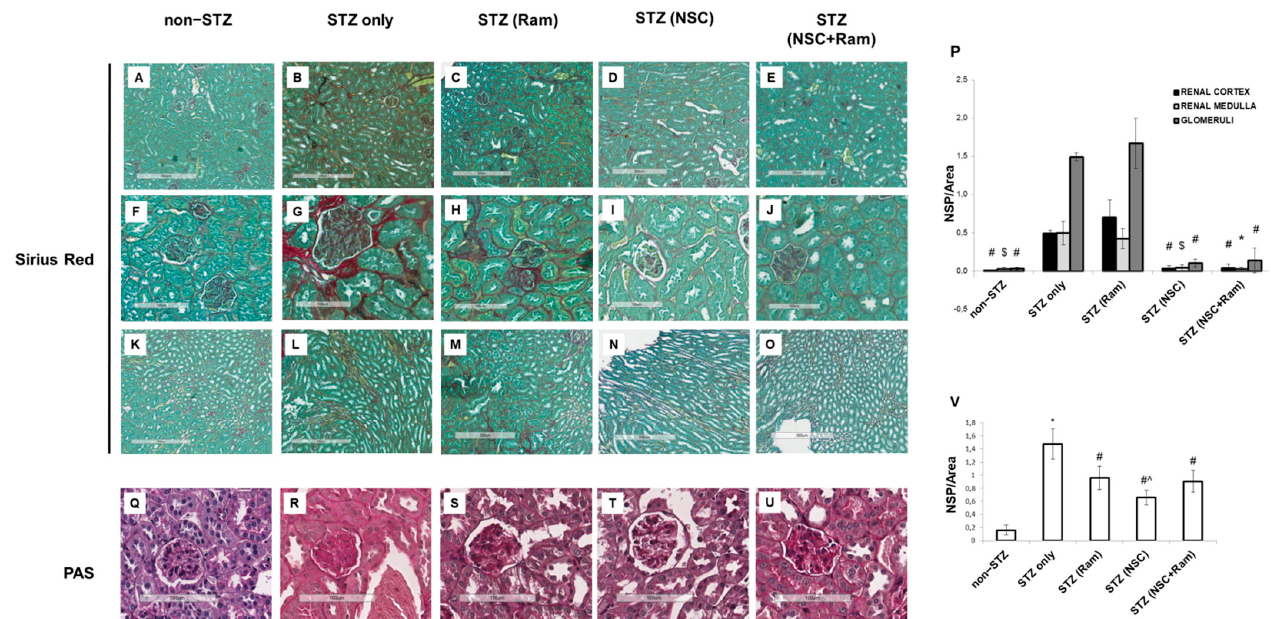
Figure 3. NSC697923 effect, alone and in combination with ramipril, on Sirius Red staining and PAS staining in the renal cortex and medulla of STZ-treated DBA/2J mice. ( A – O , P ). Collagen expression evaluated by Sirius Red staining on five different groups of animals, each group including at least four different animals. Sirius Red staining was quantified by analyzing the mean number of strong positives on the area analyzed. Error bars indicate standard deviation. ( Q – U , V ). Representative PAS staining of glomeruli from five different groups of animals, each group including three different animals. PAS staining was quantified analyzing the mean number of strong positive on the area analyzed. Error bars indicate standard deviation. Non-diabetic animals are indicated as non-STZ; diabetic animals that did not receive any other compound are indicated as STZ-only; diabetic animals treated with either ramipril, NSC697923, or the combination are indicated respectively as STZ (Ram), STZ (NSC), and STZ (NSC + Ram). * p < 0.05 vs. STZ only; $ p < 0.005 vs. STZ only; # p < 0.0005 vs. STZ only; ° p < 0.0001 vs. non-STZ; ^ p < 0.005 vs. STZ (Ram) and STZ (NSC+Ram).